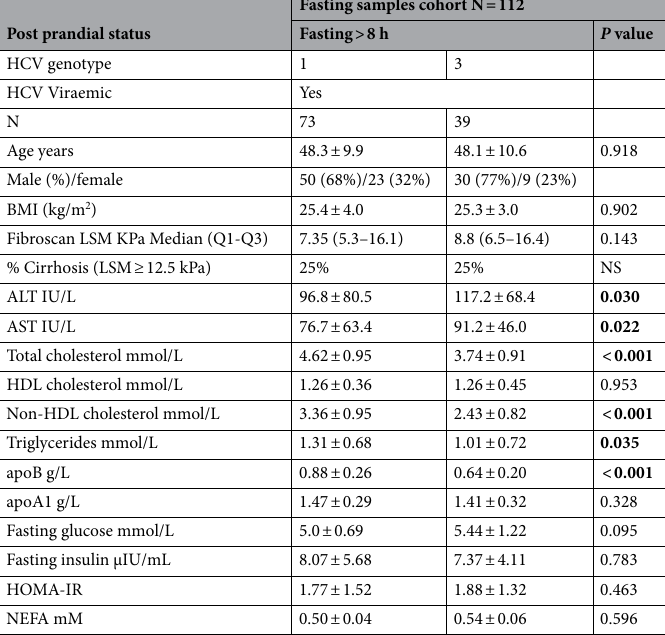
Table 1. Clinical and laboratory characteristics of fasting cohort. NEFA non-esterified fatty acids, HOMA-IR Homeostatic Model Assessment for Insulin Resistance. Significant values are in